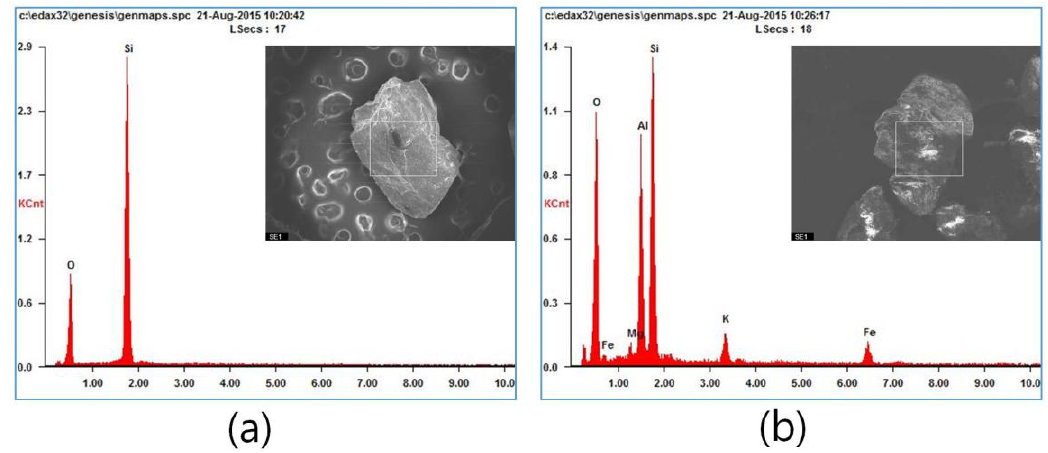
Figure 7. EDX analyses of the sea sand and fine soil sand before the cleaning process (four-year-old samples). ( a ) Sea sand and ( b ) fine soil